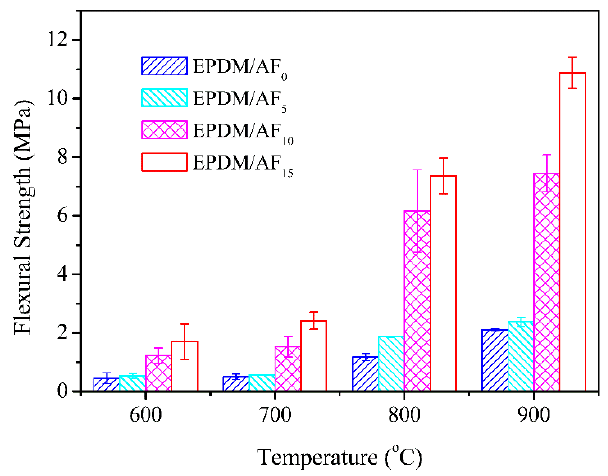
Figure 4. Flexural strength of ceramifiable EPDM composites at different temperatures.